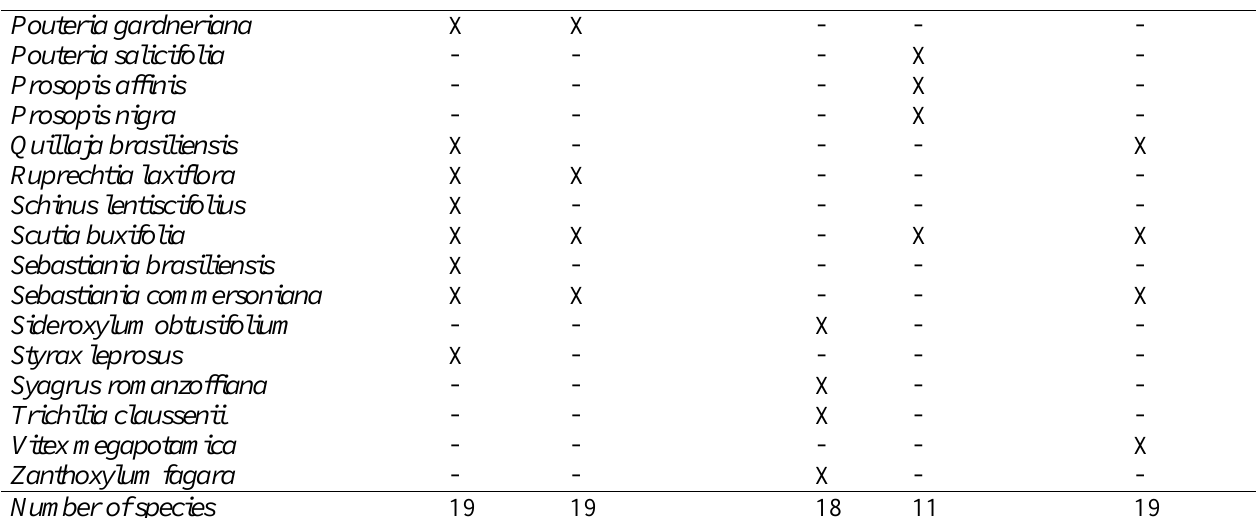
Figure 4. Relationship among five environments of the Pampa biome based on occurrence of economically important tree species. The dendrogram was drawn based on Jaccard`s Index of similarity [ J = ( A∩B )/( A U B )] and the unweighted pair group method with ( A,B ) arithmetic mean (UPGMA)